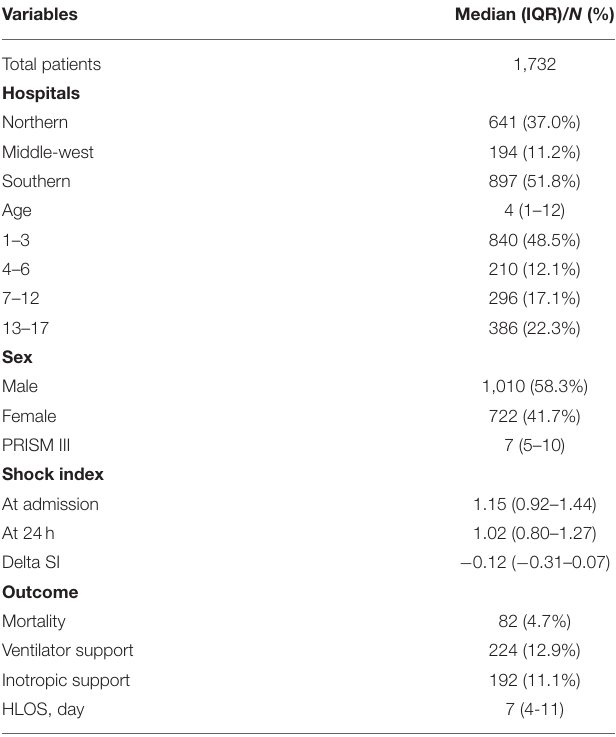
TABLE 2 | Demographics and clinical characteristics of the included patients.